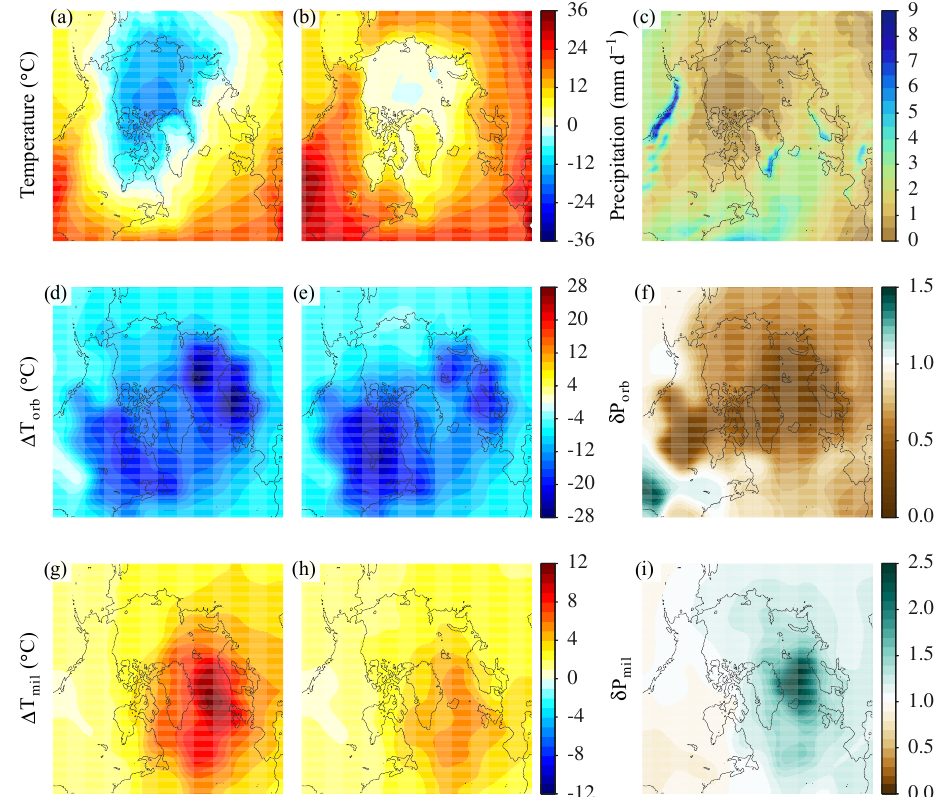
Figure 2. Spatial components of the different methods. The reference climate is based on the ERA-INTERIM (1981–2010) reanalysis (Dee et al., 2011) and consists of (a) annual SAT ( ◦ C); (b) summer (JJA) SAT ( ◦ C) and (c) annual precipitation (mmd − 1 ). The orbital component of the spatial forcing comprises the anomalies between the LGM and the present-day climates obtained from the CLIMBER-3 α model (Montoya and Levermann, 2008): (d) annual SAT ( ◦ C), (e) summer (JJA) SAT ( ◦ C) and (f) annual precipitation ratio ( δP orb = P lgm /P pd ). Panels (g–i) show the same fields as in (d–f) for the millennial component of the spatial forcing generated from the combination of the Is and the St climatic states simulated by CLIMBER-3 α (Banderas et al., 2012, 2015). All variables have been corrected by elevation assuming a linear vertical atmospheric profile (see Sect.